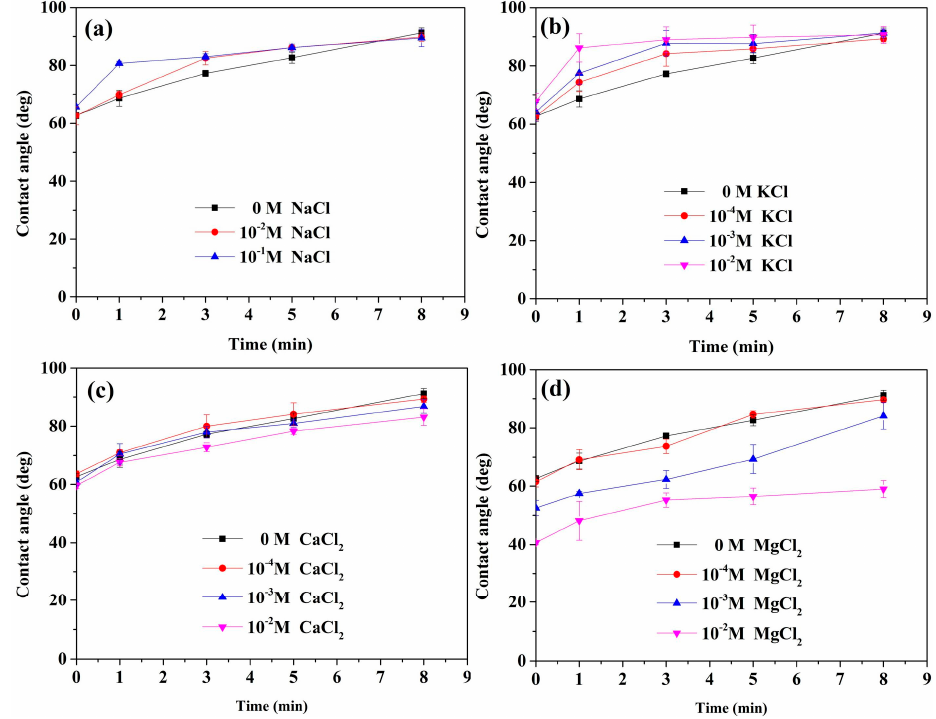
Figure 3. Contact angle of chalcopyrite surface exposed to collectors for various times in ( a ) NaCl; ( b ) KCl; ( c ) CaCl 2 ; and ( d ) MgCl 2 solution. Each measurement was finished within 30 s.